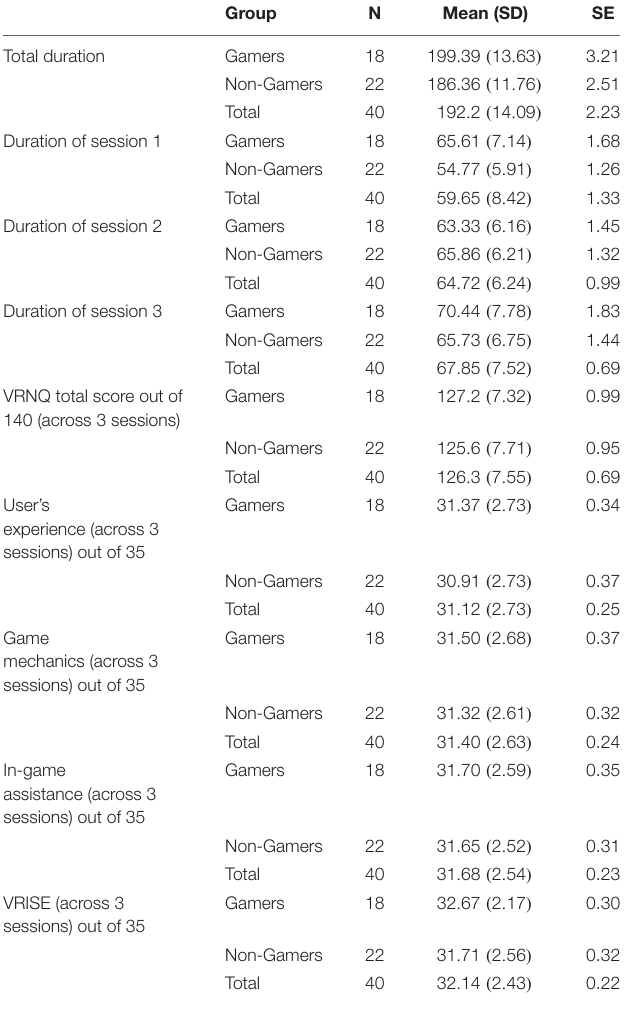
TABLE 3 | Descriptive statistics: duration of VR sessions and VRNQ